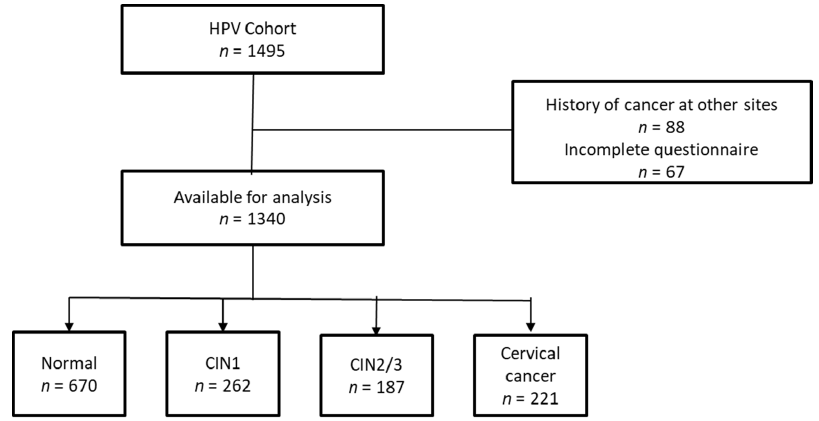
Figure 1. Flow diagram of included study subjects. (HPV, human papillomavirus; CIN, cervical intraepithelial neoplasia).